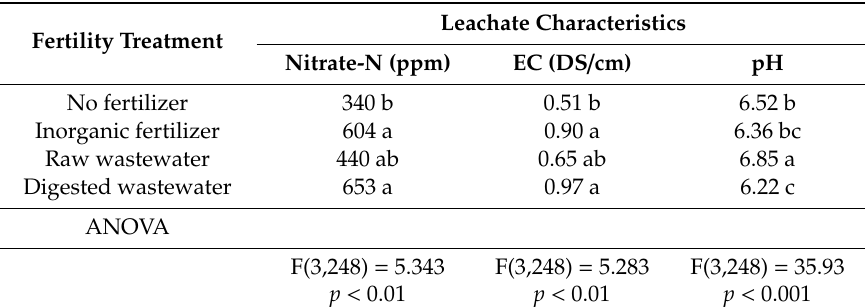
Table 4. Leachate measurements (Nitrate-N, EC, and pH) for each fertility treatment averaged across 6 weeks and crops (mustard greens, lettuce, and basil) grown with di ff erent fertility treatments in a greenhouse in St. Paul, MN in 2018.Values within the same column with di ff erent letters are significantly di ff erent (Tukey’s HSD, α =